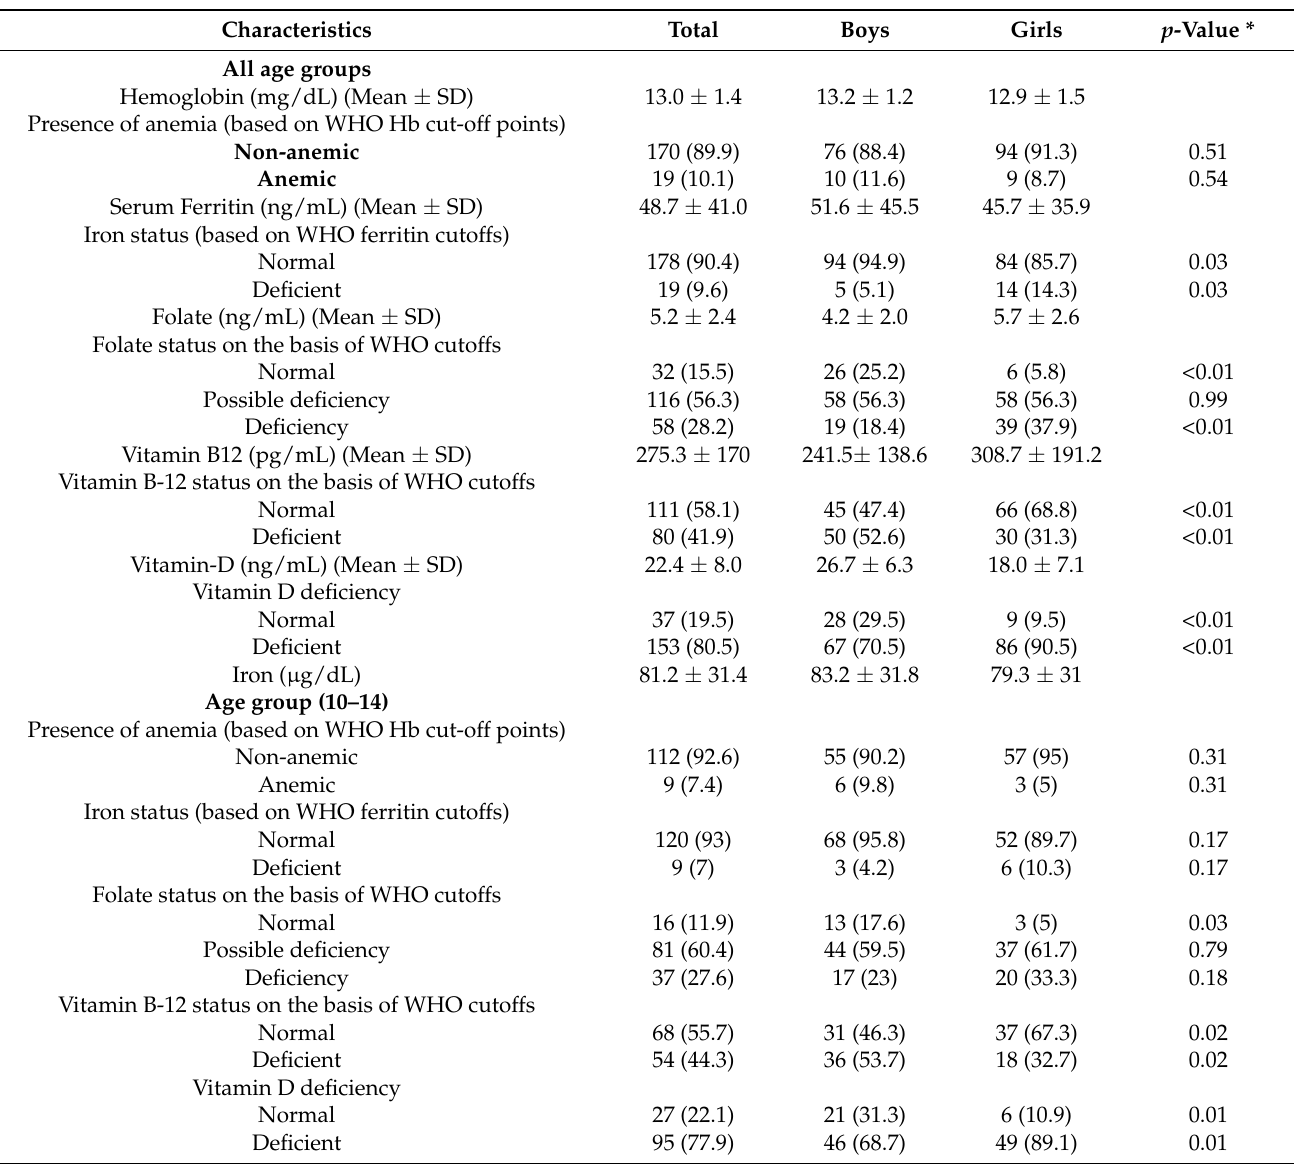
Table 3. The micronutrient status of the